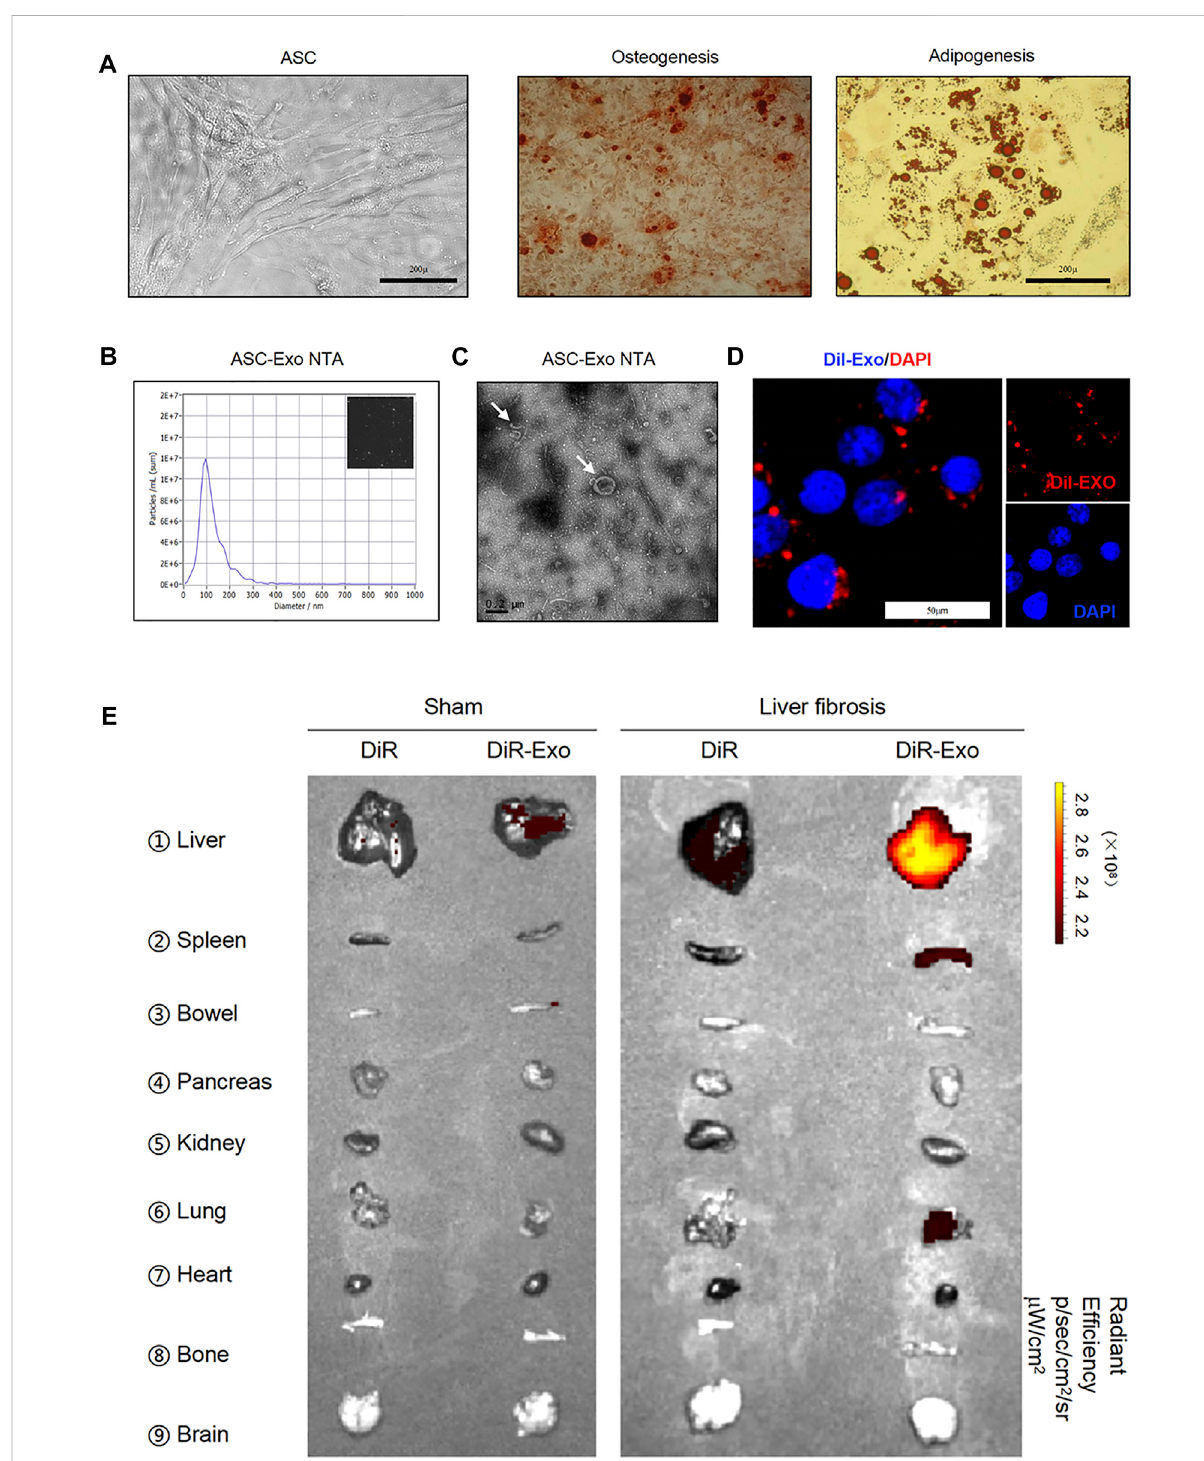
FIGURE 3 Isolation and identi fi cation of exosomes released and up-taken by primary HSCs. (A) Images of human adipose tissue-derived mesenchymal stem cells (ASCs) (left panel). Two groups of ASCs were subjected to osteogenic (middle panel) or adipogenic differentiation medium (right panel) and stained with Alizarin Red S or Oil Red O, respectively. Scale bar: 200 μ m. (B) Nanosight imaging of isolated exosomes. (C) Appearance of exosomes bytransmissionelectronmicroscopy. Scale bar: 0.2 μ m. (D) PrimaryHSCs were incubated for 24 hwith Dil labeled-exosomes. Cells werevisualizedforexosome fl uorescence(red)andDAPI(blue)byconfocalmicroscopy. (E) ImagesofisolatedorgansanalyzedforpresenceofDiR- exosomes in sham (left panel) and liver fi brosis (right